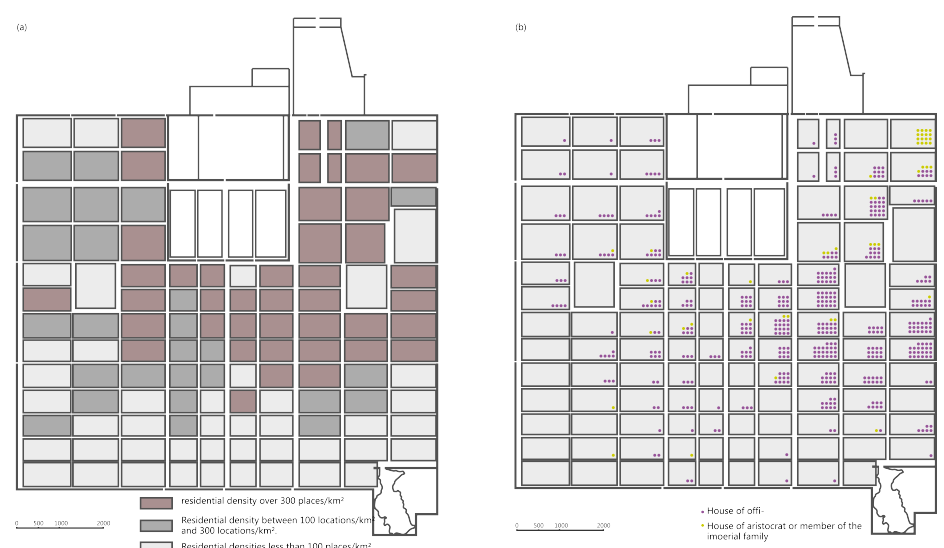
Figure 22. ( a ) Residential Density Distribution Map based on Zhang Yongshuai’s “Study of Tang Chang’an Housing [71]”. ( b ) Map of aristocratic and bureaucratic residences in Chang’an, Tang Dynasty, based on Wang Caiqiang’s “Digital Reconstruction of Chang’an, Tang Dynasty